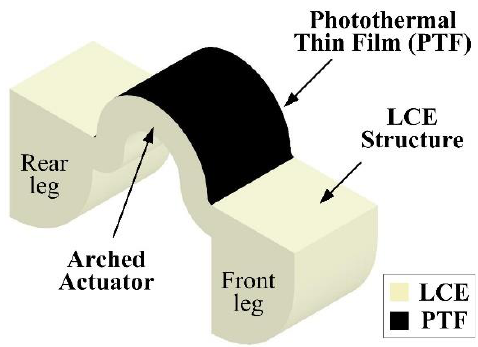
Figure 1. Schematic of a light-driven LCE device with PTF.